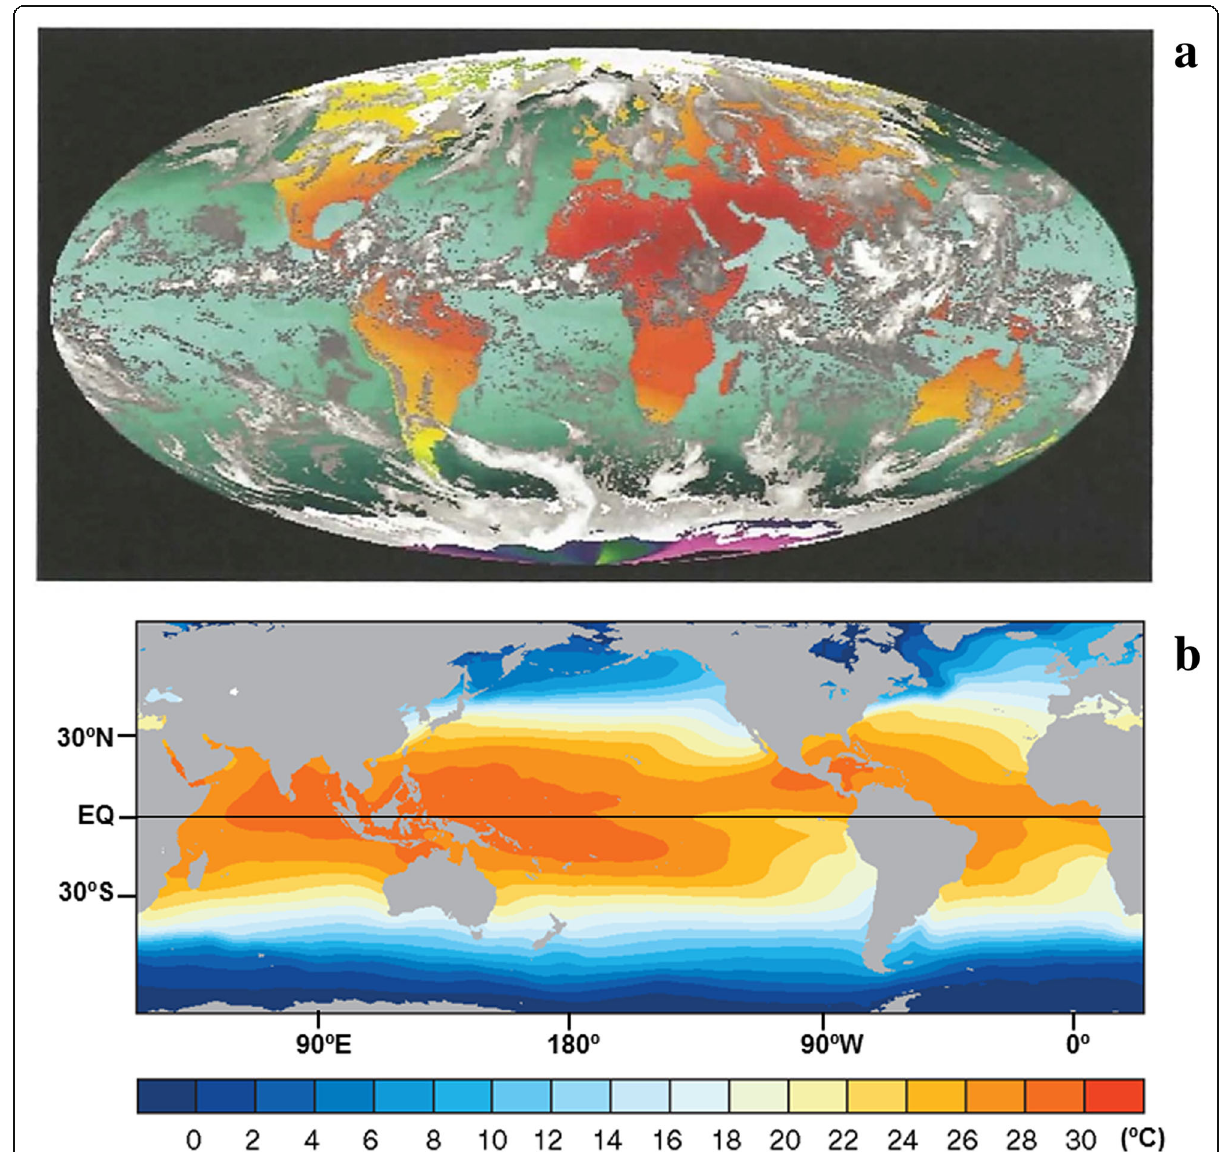
Fig. 4 Distributions of a OLR (sea, land, and cloud top) temperature (snapshot, originally from the University of Wisconsin) and b SST (annual mean, originally from UK Meteorological Office). Copied from figs. 1.27 and 2.11 of Wallace and Hobbs